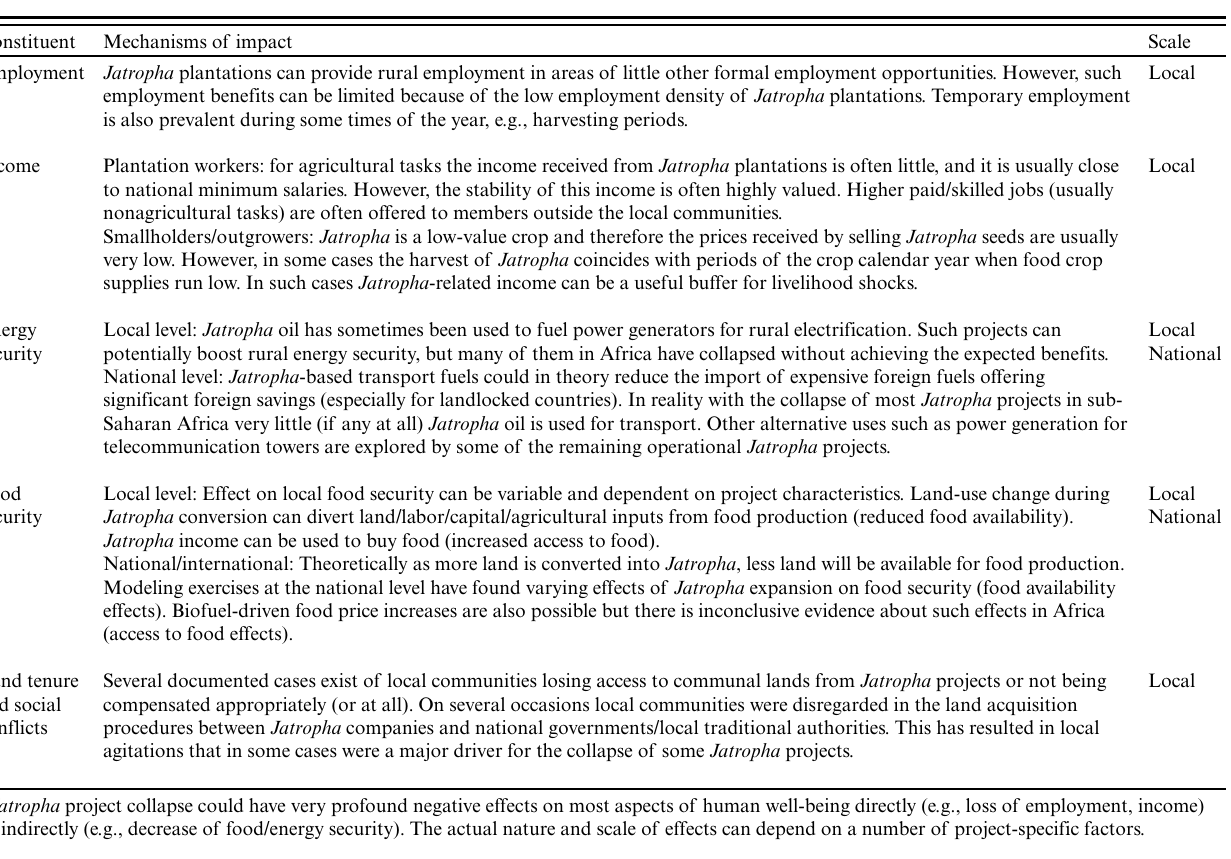
Table 2 . Human well-being impacts of Jatropha cultivation in sub-Saharan Africa † . Adapted from Gasparatos et al. 2012,